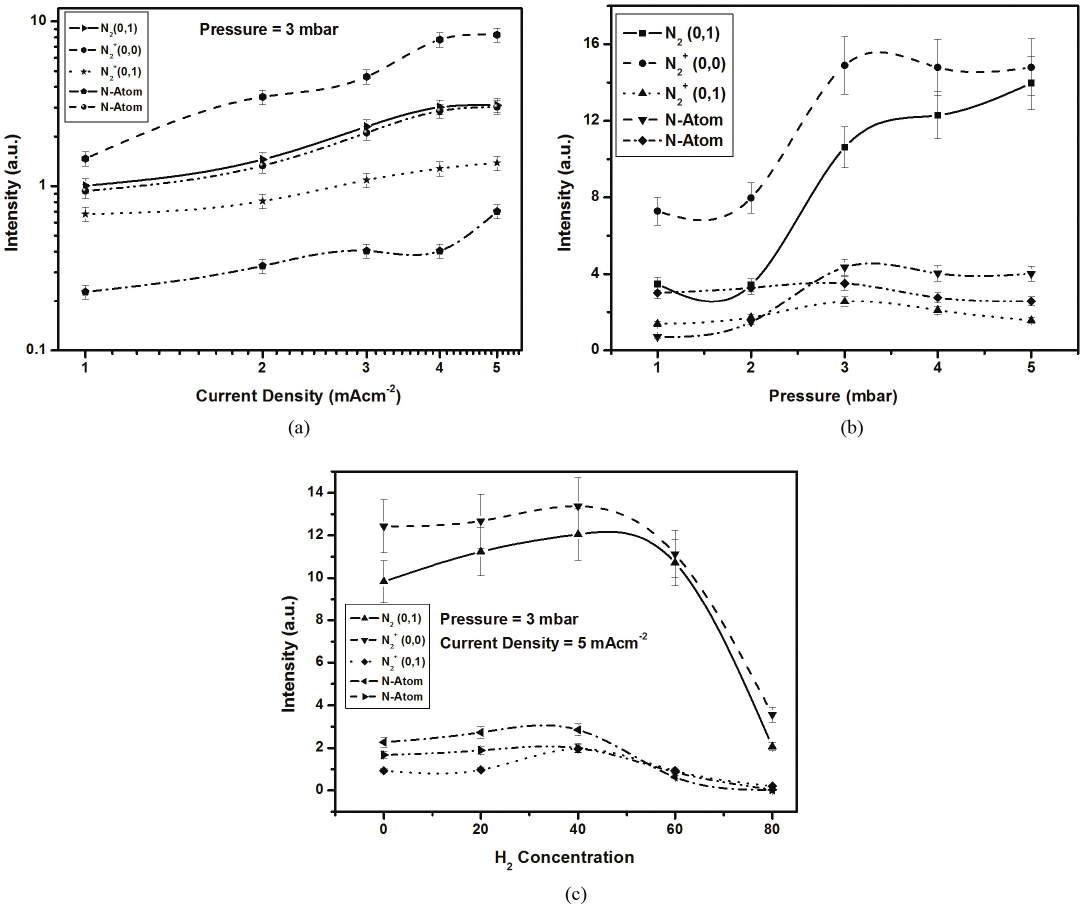
Figure3. Variation of emission intensities as a function of (a) current density at 3 mbar pressure (b) fill pressure at 5 mAcm –2 current density (c) hydrogen concentration at 3 mbar pressure and 5 mAcm –2 current density.